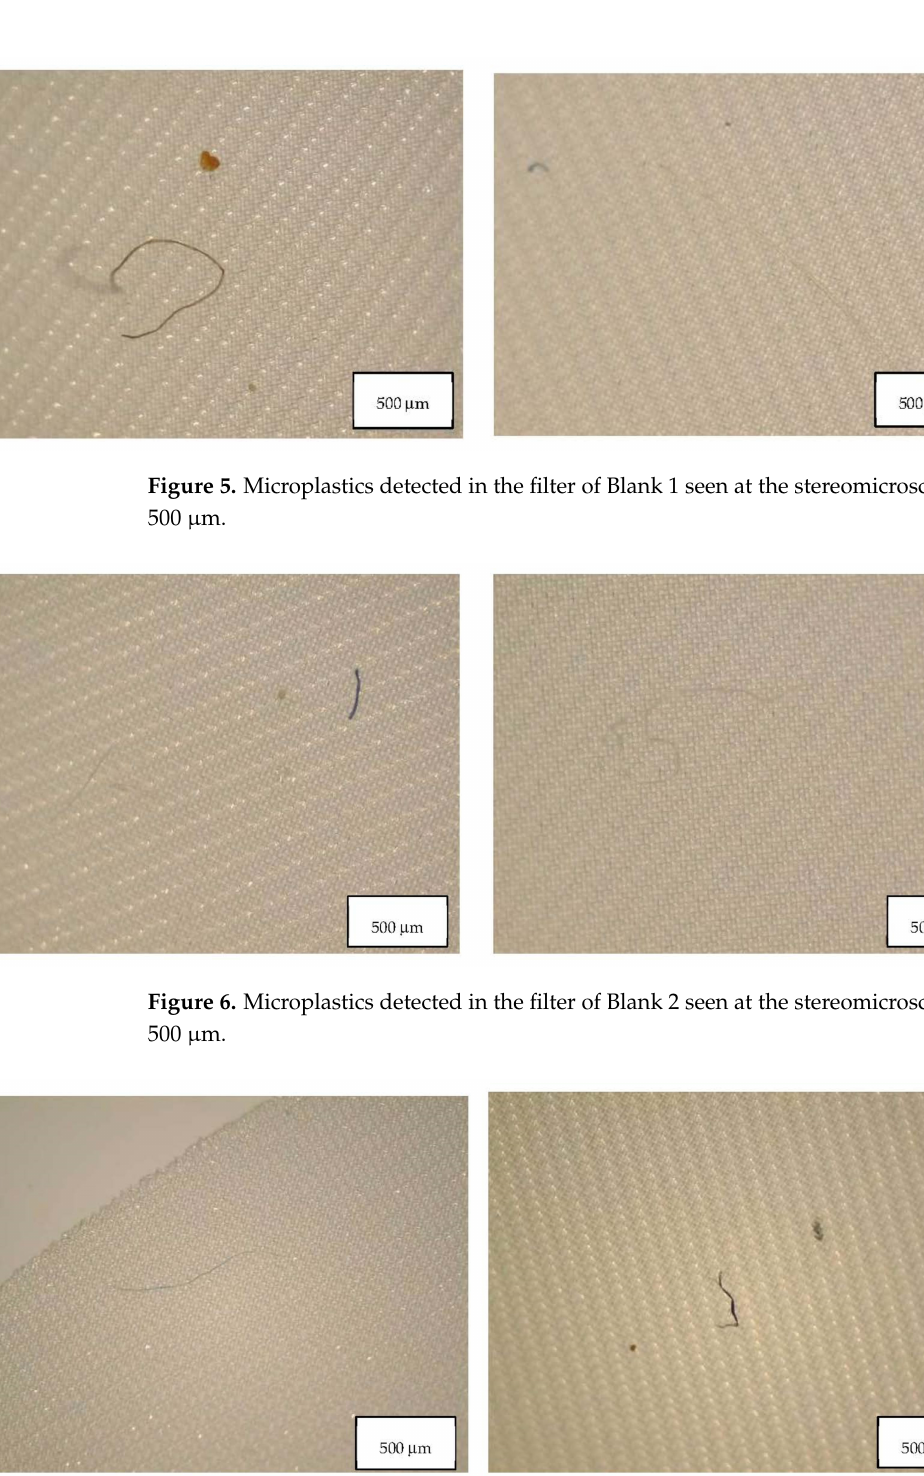
Figure 7. Microplastics detected in the filter of Blank 3 seen at the stereomicroscope with scale bar of 500 µ